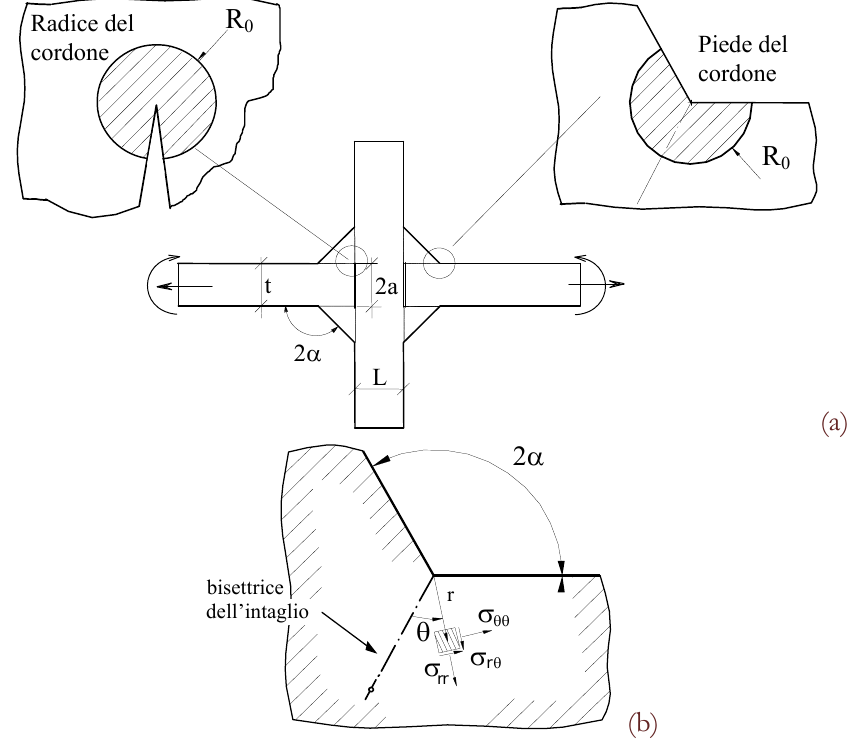
Figura 1: Volume (area) di controllo posizionato al piede e alla radice dei cordoni di saldatura (a); sistema di coordinate polari e componenti di tensione